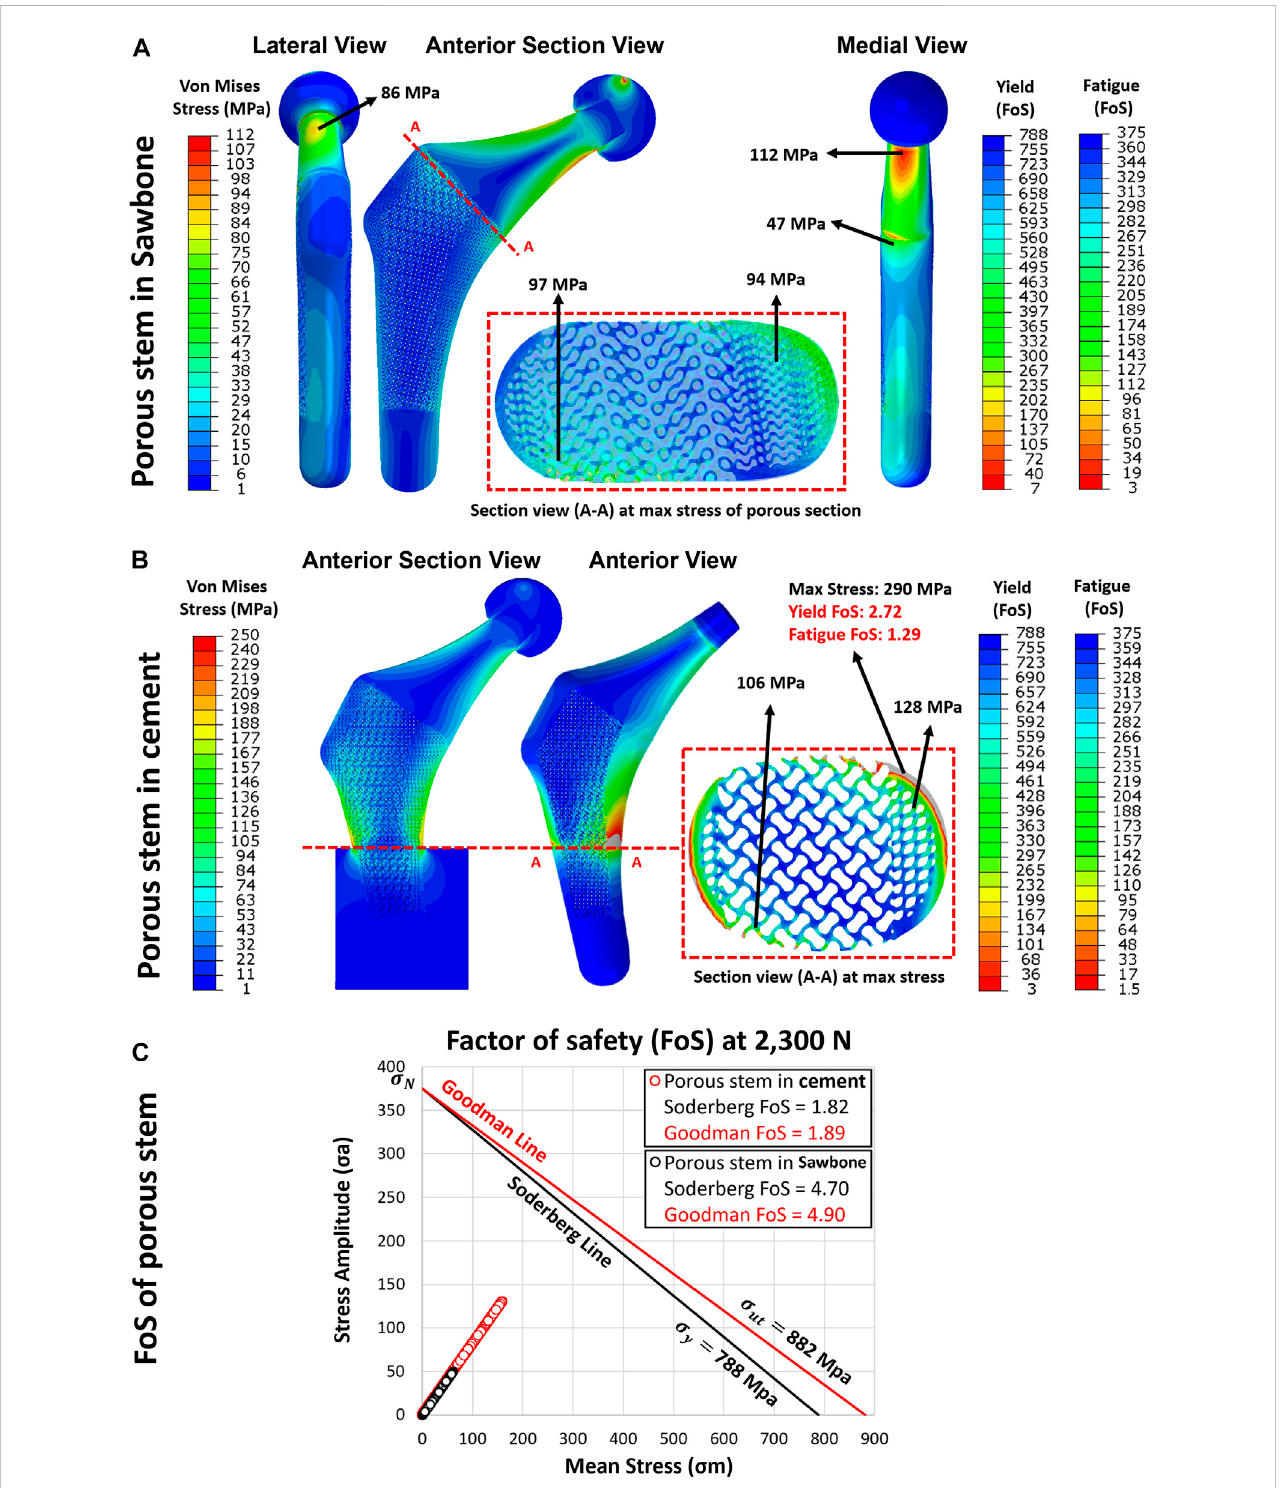
FIGURE 10 The yield and fatigue factor of safety distribution for implanted porous stem within (A) Sawbone and (B) cement, loaded at 2,300 N. (C) Fatigue factor of safetyforeachelementintheporousstemimplantedwithinSawbone(blackcircle)andPMMAbonecement(redcircle),examinedthroughtheSoderbergand Goodman fatigue theory loaded at 2,300